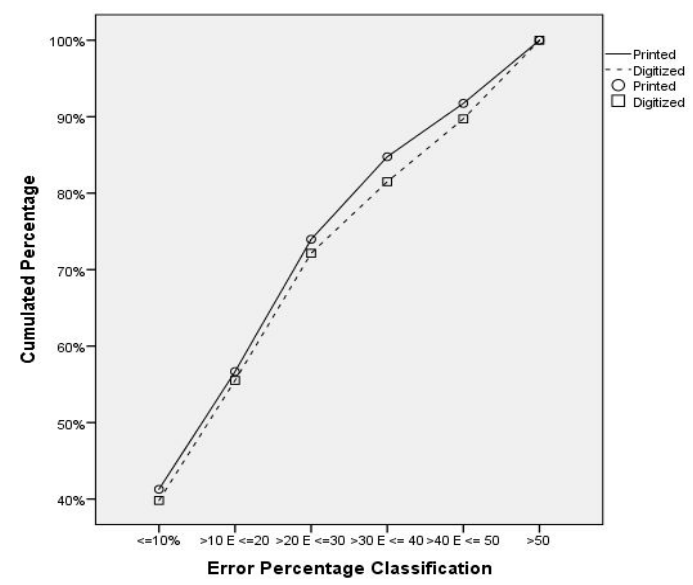
Figure 1. Cumulated percentage of perception assessments in relation to error percentage classification. Table 3. Mean values and standard deviation of the total error of printed and digital photos, according to the characteristics of participants, portion size, type of presentation and consumption of foods ( n = 58